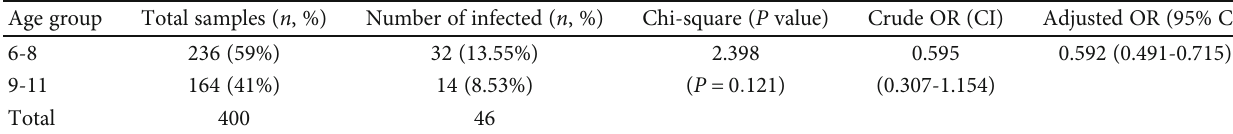
Table 3: Age-wise distribution of parasitic infection.